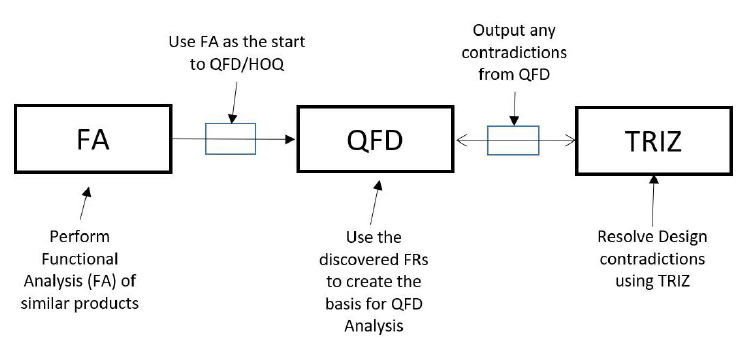
Figure 6. FA, QFD, and TRIZ Tool Integration [32].